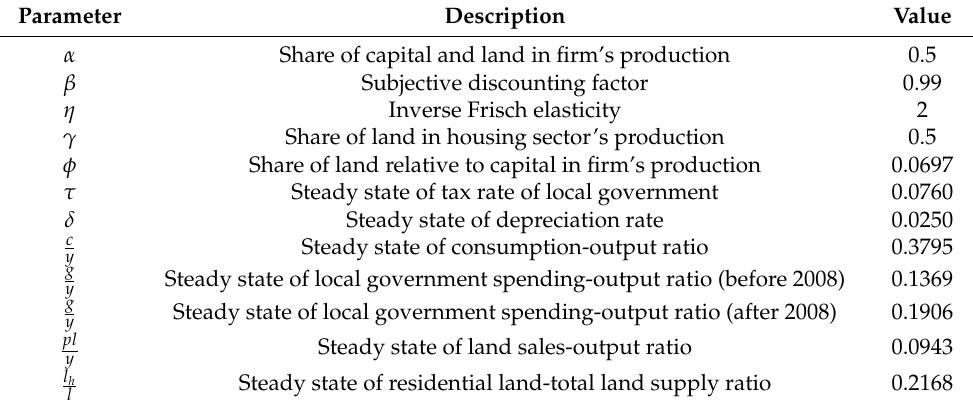
Table 4. Values of